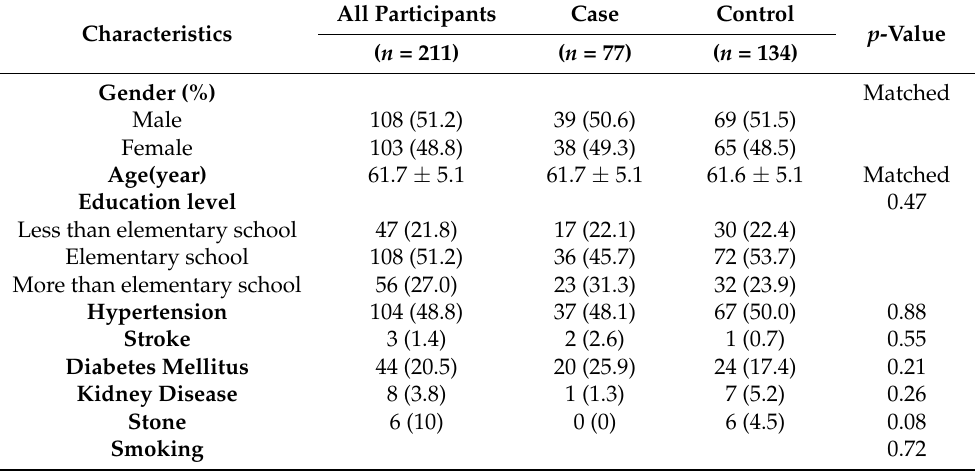
Table 1. Baseline characteristics of participants by coronary artery disease (CAD)